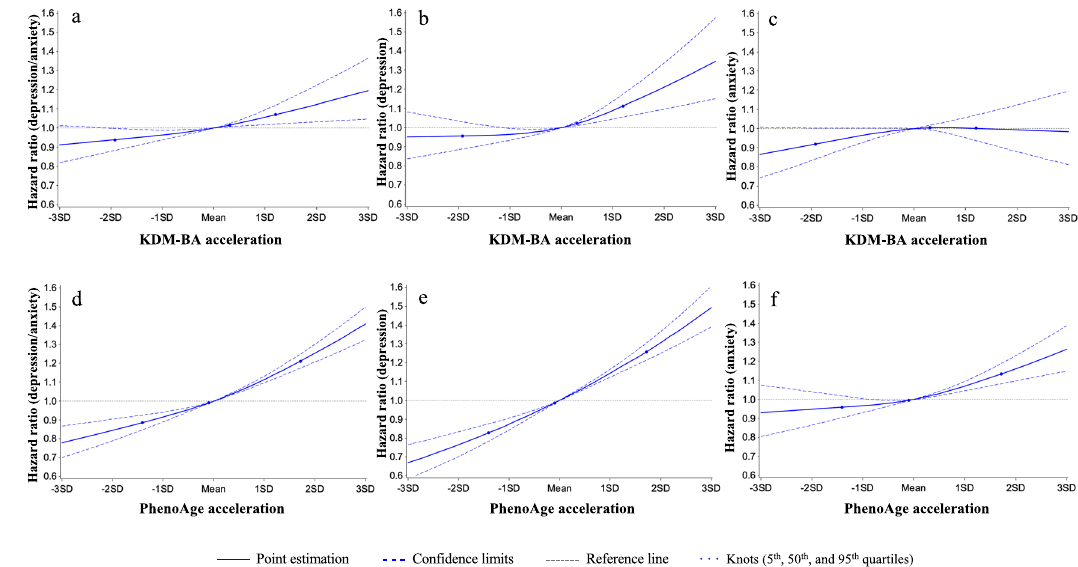
Fig. 2 | Graphs of the best fi tting models for relationships of KDM-BA accel- erationandPhenoAgeaccelerationwithincidentdepression/anxietydisorders atfollow-up. Panels: KDM-BA acceleration( a – c ) and PhenoAge acceleration ( d – f ). Solid line: Point estimation; Black dash line: Con fi dence limits; Green dash line: Referenceline;Dots:Knots(5th,50th,and95thpercentiles).Restrictedcubicspline